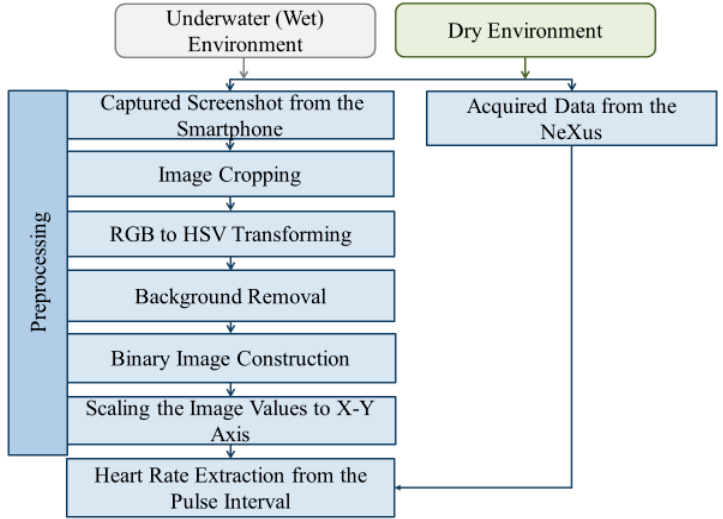
Figure 3. The flowchart of our proposed data processing procedure which consists of acquiring screenshot during the measurement, cropping acquired images, converting RGB image to HSV color space, obtaining a binary image after denoising background from HSV images, and scaling a binary image to values in x-y axis. The heart rate is extracted from peak-to-peak (or pulse) interval from the constructed PPG signal (left). The acquired smartphone PPG signal is compared to gold-standard PPG signal acquired by NeXus-10 MKII (right).